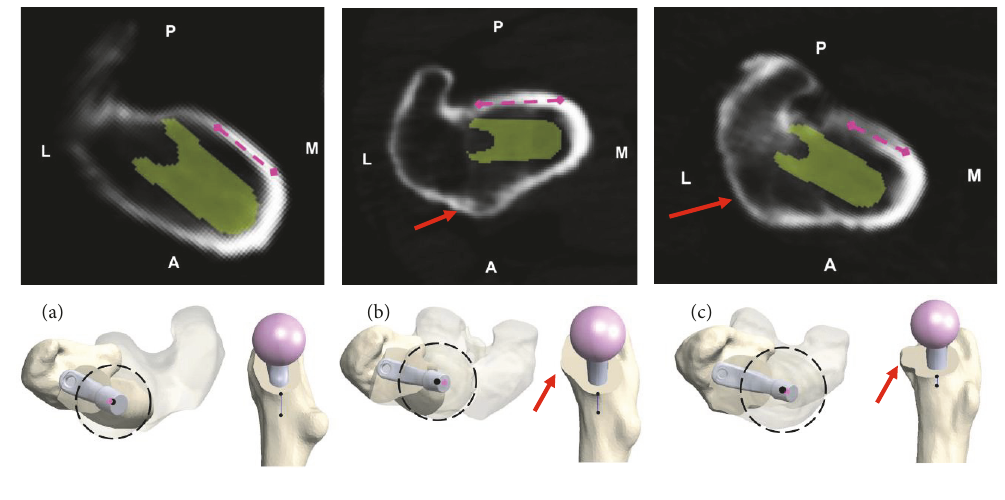
Figure 2: Case examples showing axial CT scan slices in the plane of the planned femoral neck osteotomy, with corresponding 3D reconstructionsintheaxialandsagittalplanes(redarrowsindicateanteriorfemoralneckosteophyte):(a)noanteriorfemoralneckosteophyte; (b) minor osteophyte; (c) extensive